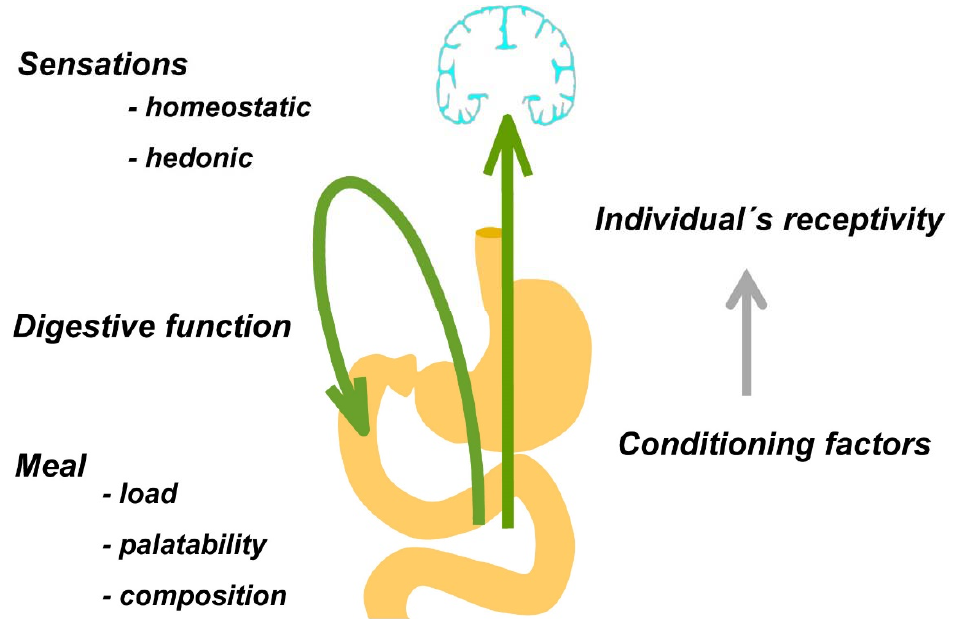
Figure 3. Biological responses to food ingestion. Meal ingestion induces digestive and sensory responses. Homeostatic (satiety, fullness) and hedonic sensations (digestive well-being and mood) depend on the characteristics of the meal, the digestive response, and the individual’s receptivity, which can be influenced by multiple conditioning factors. Adapted from reference [1].